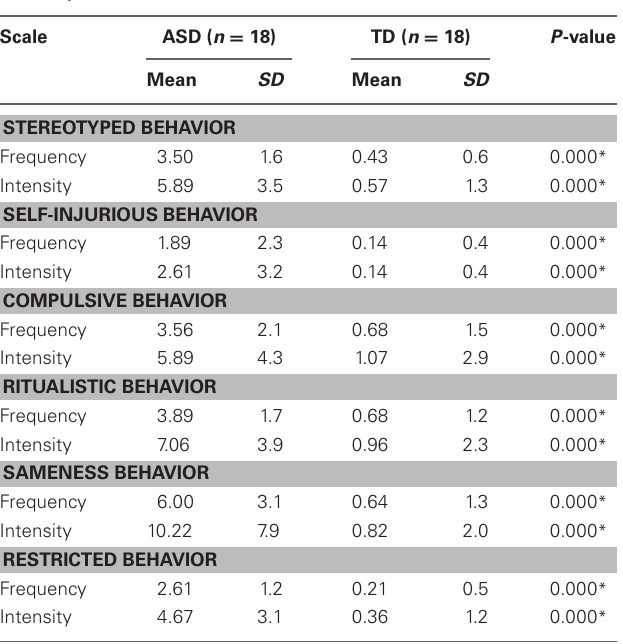
Table 3 | Means and standard deviations (SD) for scores on